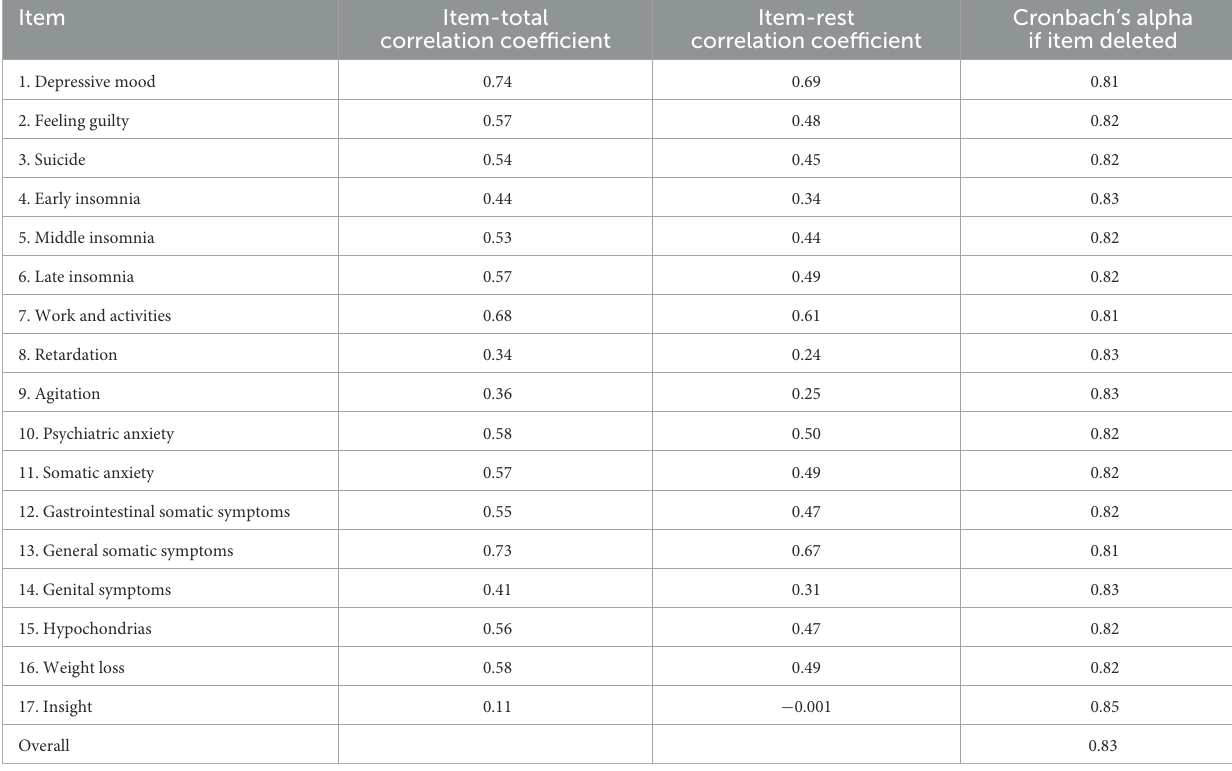
TABLE 2 Internal reliability of the Vietnamese version of the Hamilton D-17 ( N =